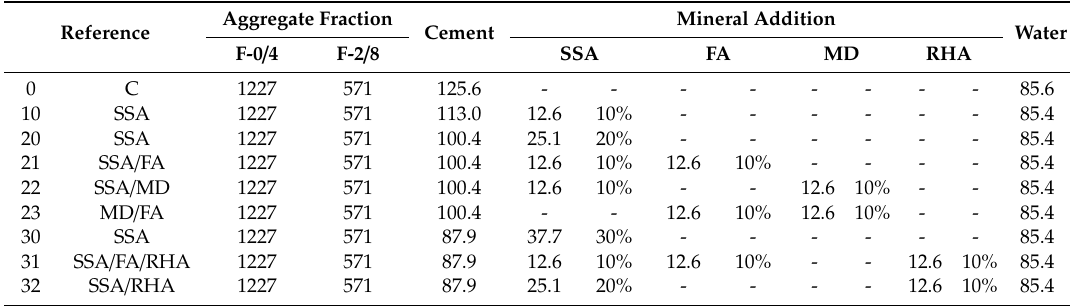
Table 1. Concrete mix proportioning (kg / m 3 ) and dosages of mineral additions (SSA: sewage sludge ash; FA: fly ash; MD: marble dust; RHA: rice husk